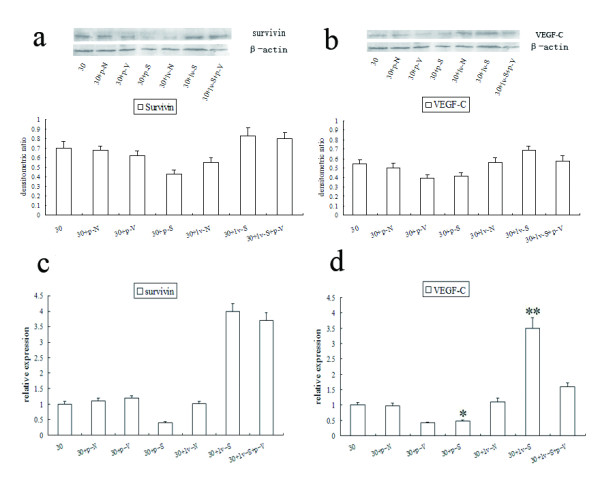
Expression of survivin and VEGF-C in different processed cells at protein and mRNA level.a and b: western blot analysis for protein expression; c and d: real-time PCR for mRNA expresison. * means statistically significant decrease comparing to 30, and ** means statistically significant increase comparing to 30 (both p<0.05). (30 = ZR-75-30 breast cancer cell line; p-N = plasmid with negative control; lv-N = lentivirus with negative control; p-S = survivin shRNA; p-V = VEGF-C shRNA; lv-S = lentivirus with survivin gene).